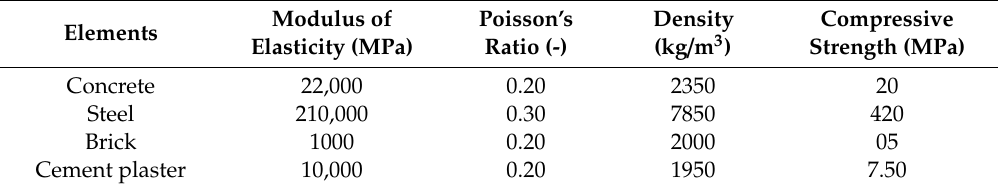
Table 2. Material properties used in the initial finite element model.